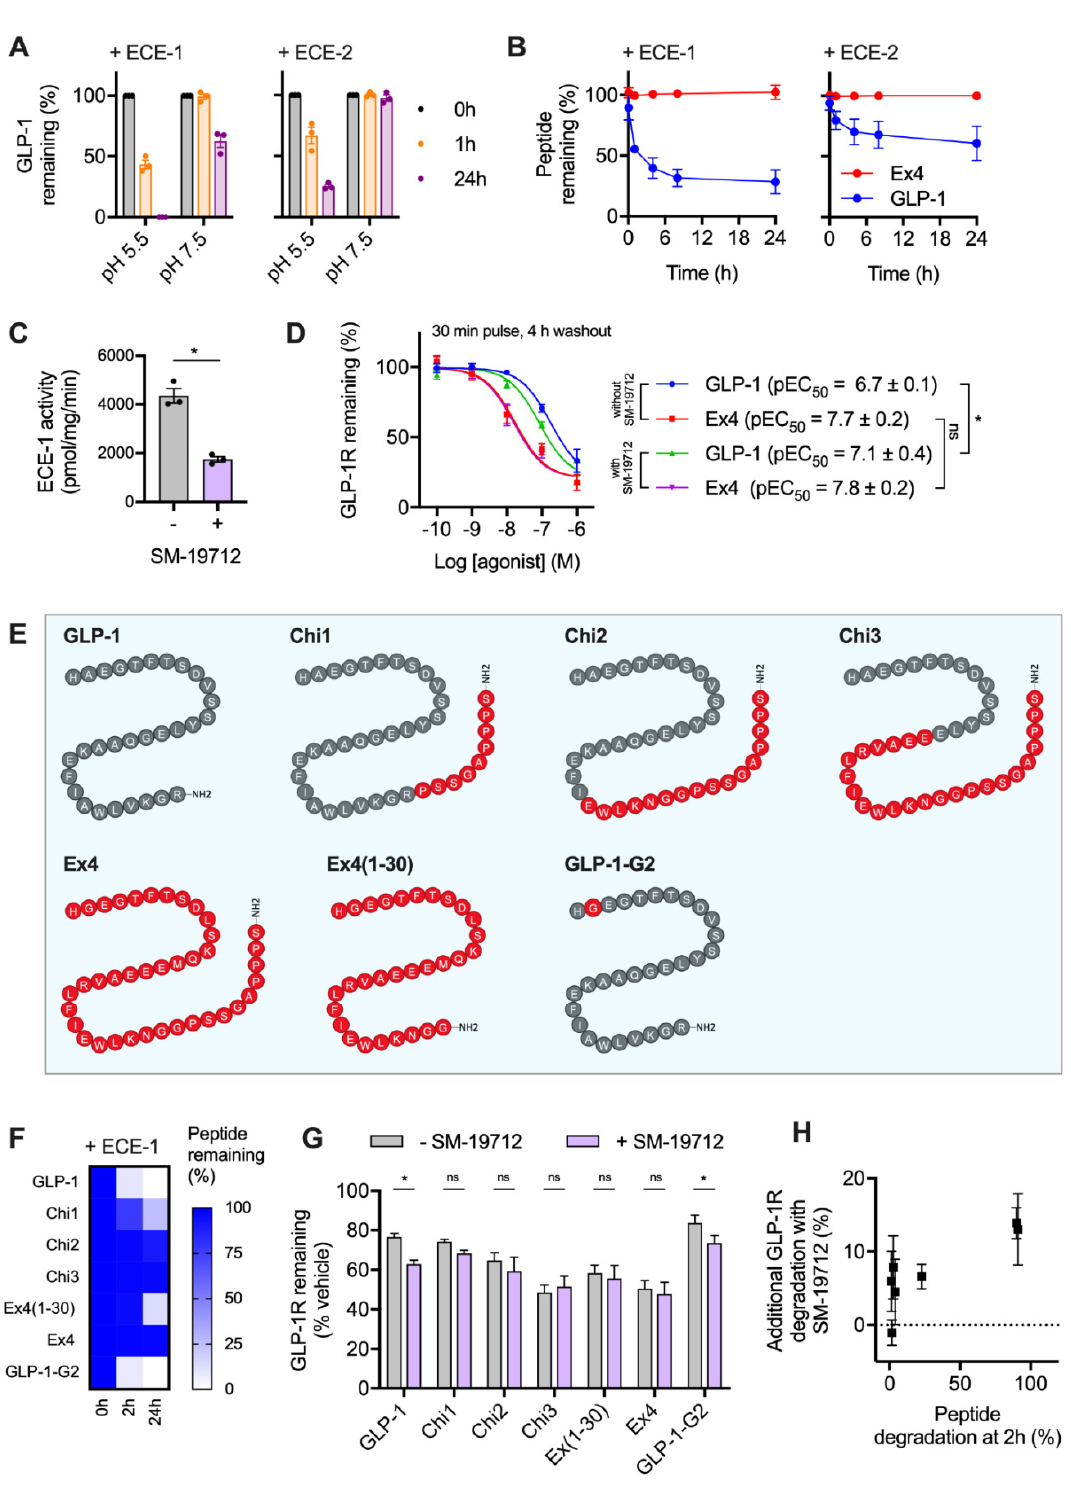
Figure 2. GLP-1R degradation is partly influenced by ECE-1-mediated ligand proteolysis. ( A ) In vitro GLP-1 degradation at indicated pH in the presence of 0.25 µ g ECE-1 or ECE-2, determined by HPLC quantification from n = 3 experiments. ( B ) Time-course of in vitro GLP-1 versus exendin-4 degradation by ECE-1 or ECE-2 at pH 5.5, quantified from n = 2 experiments by HPLC. ( C ) ECE-1 activity measured from INS-1-SNAP-GLP-1R cell lysates ± 10 µ M SM-19712, n = 3, compared by paired t -test. ( D ) GLP-1R degradation in INS-1-SNAP-GLP-1R cells pre-treated with cycloheximide (50 µ g / mL) in serum-free medium for 60 min before application of agonist for 30 min, followed by washout and 4 h